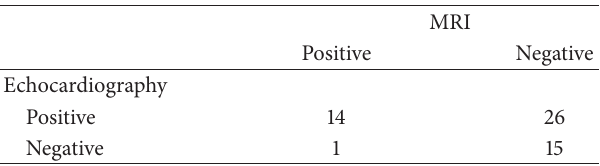
Table 2: Comparison of CMR and echocardiography for the presence or absence of LGE/fibrosis. MRI Positive Negative Echocardiography Positive 14 26 Negative 1